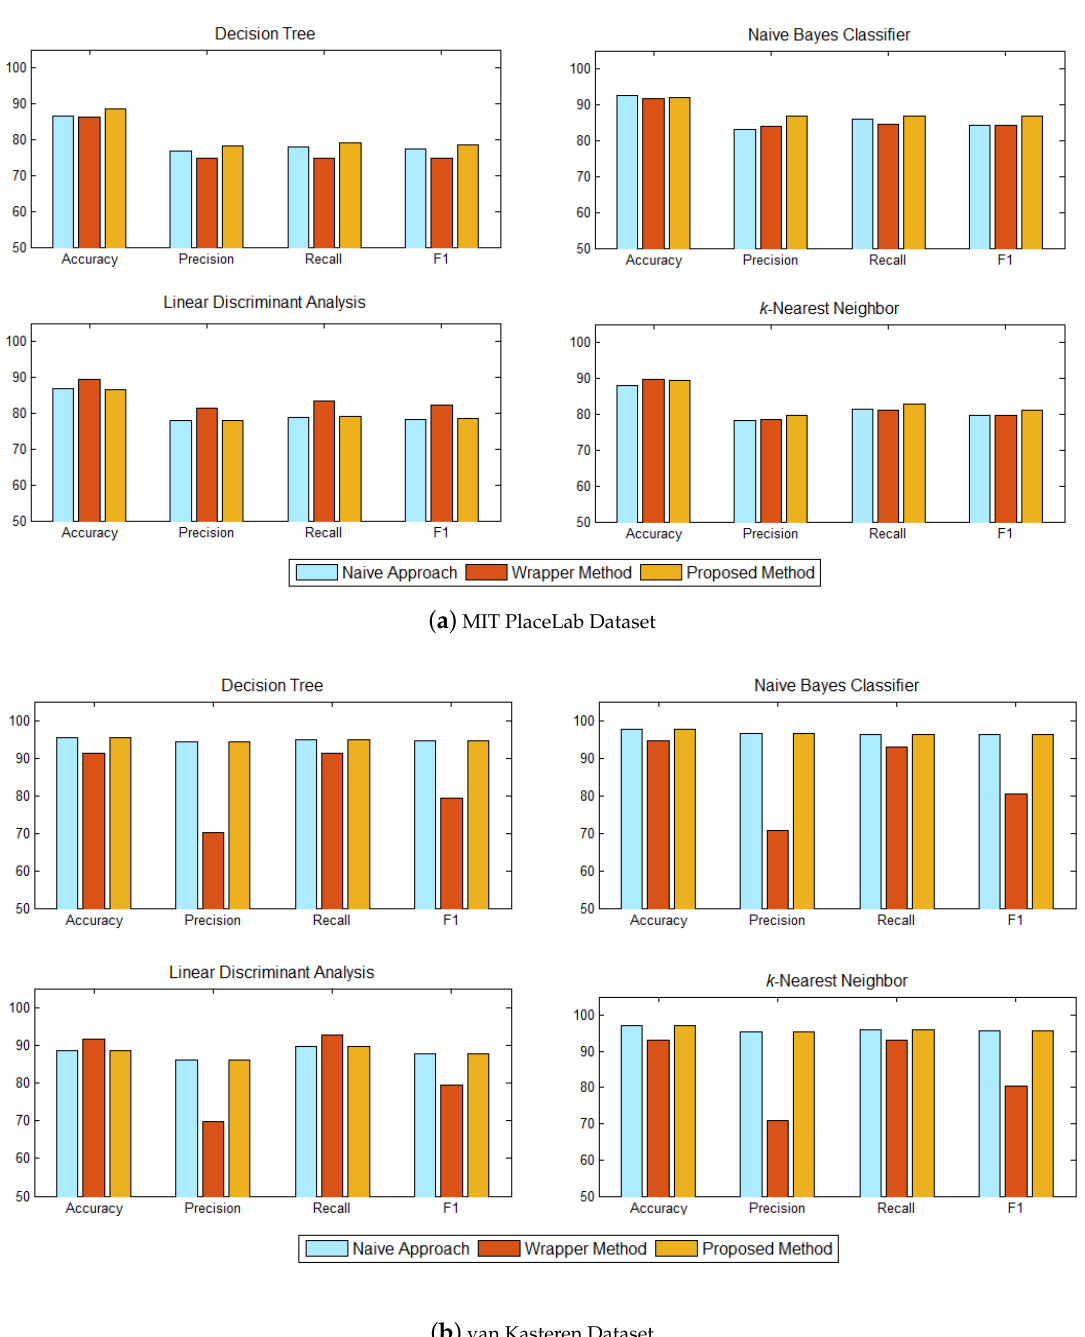
Figure 8. Recognition performance between our proposed method with baseline methods—(1) Naive approach and (2) Wrapper method with sequential forward selection in terms of accuracy, precision, recall, and F1. Each subplot shows the performance of each classifier—decision tree, naïve Bayes classifier, linear discriminant analysis, and k -nearest